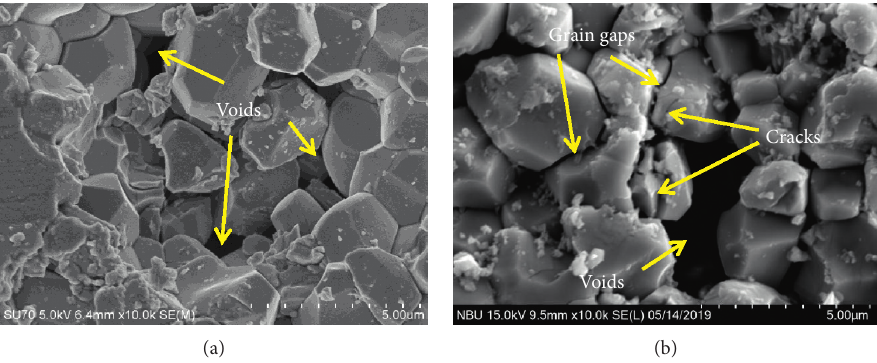
Figure 11: SEM photographs of microstructure in P51 (a) before and (b) after